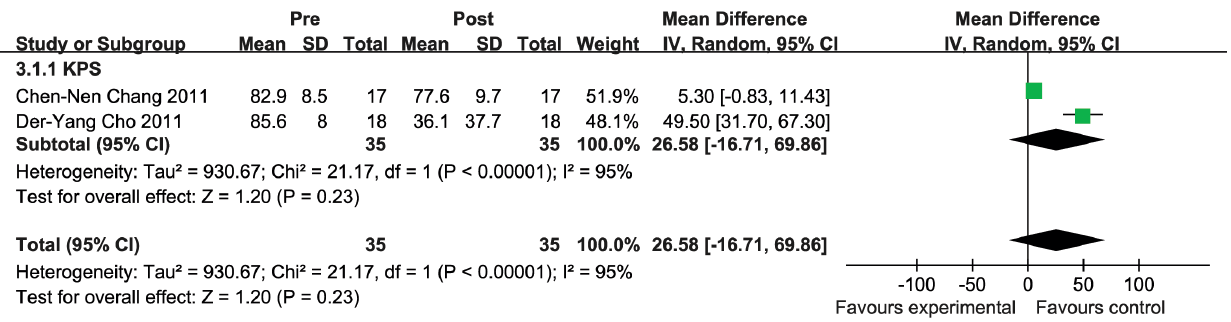
Figure 4. Forest plot for KPS before and after DC treatment. The random effects model (Mantel-Haenszel method) was used in this analysis.